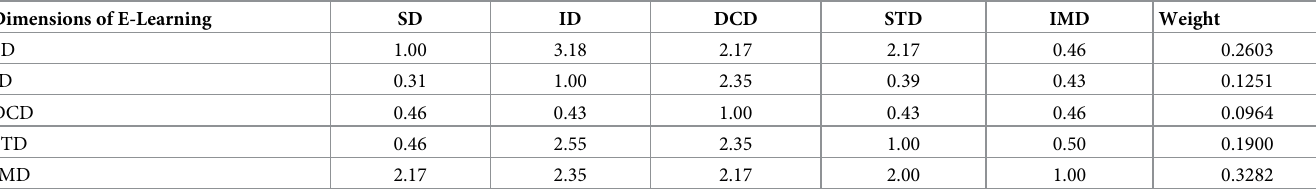
Table 8. Synthesized pairwise comparison of E-Learning dimensions by DM1 to DM5 using GM. Dimensions of